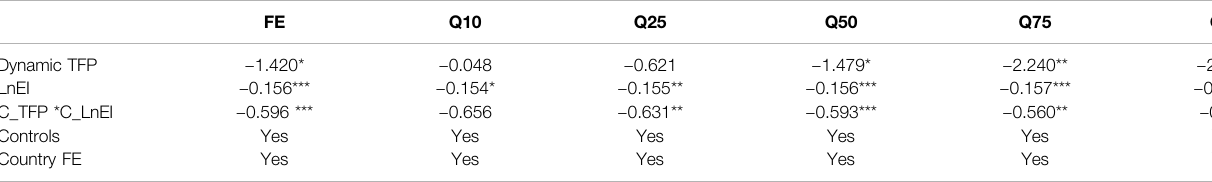
TABLE 6 | The estimation results for moderating effect with the fi xed effect and MM-QR models.